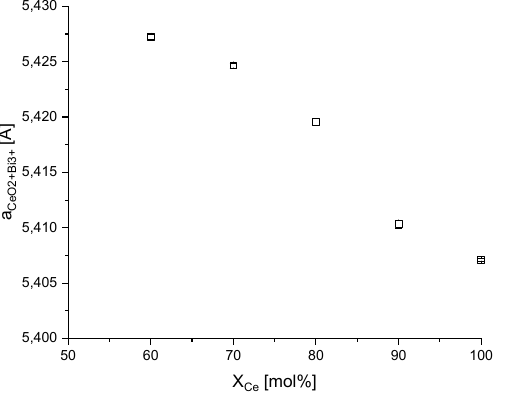
Figure 3. Lattice parameter a with standard deviation (STD) of a of cubic fluorite-type Bi 3 + -doped CeO 2 phase in dependence of the nominal molar Ce content determined by Rietveld refinement with the program TOPAS